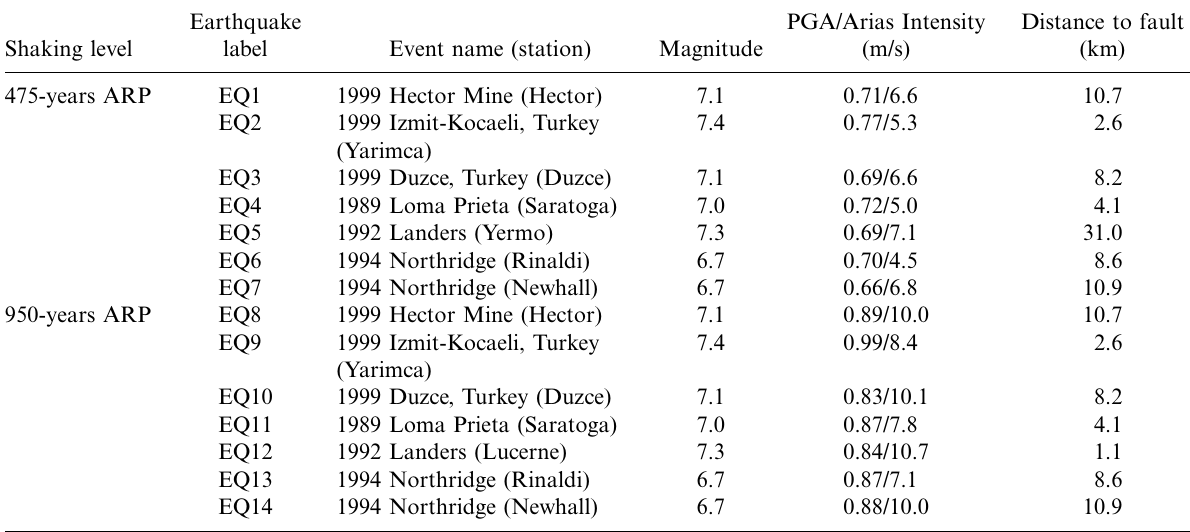
Table 2. Ground motion records (AlHamaydeh, Hussain 2010) Shaking level